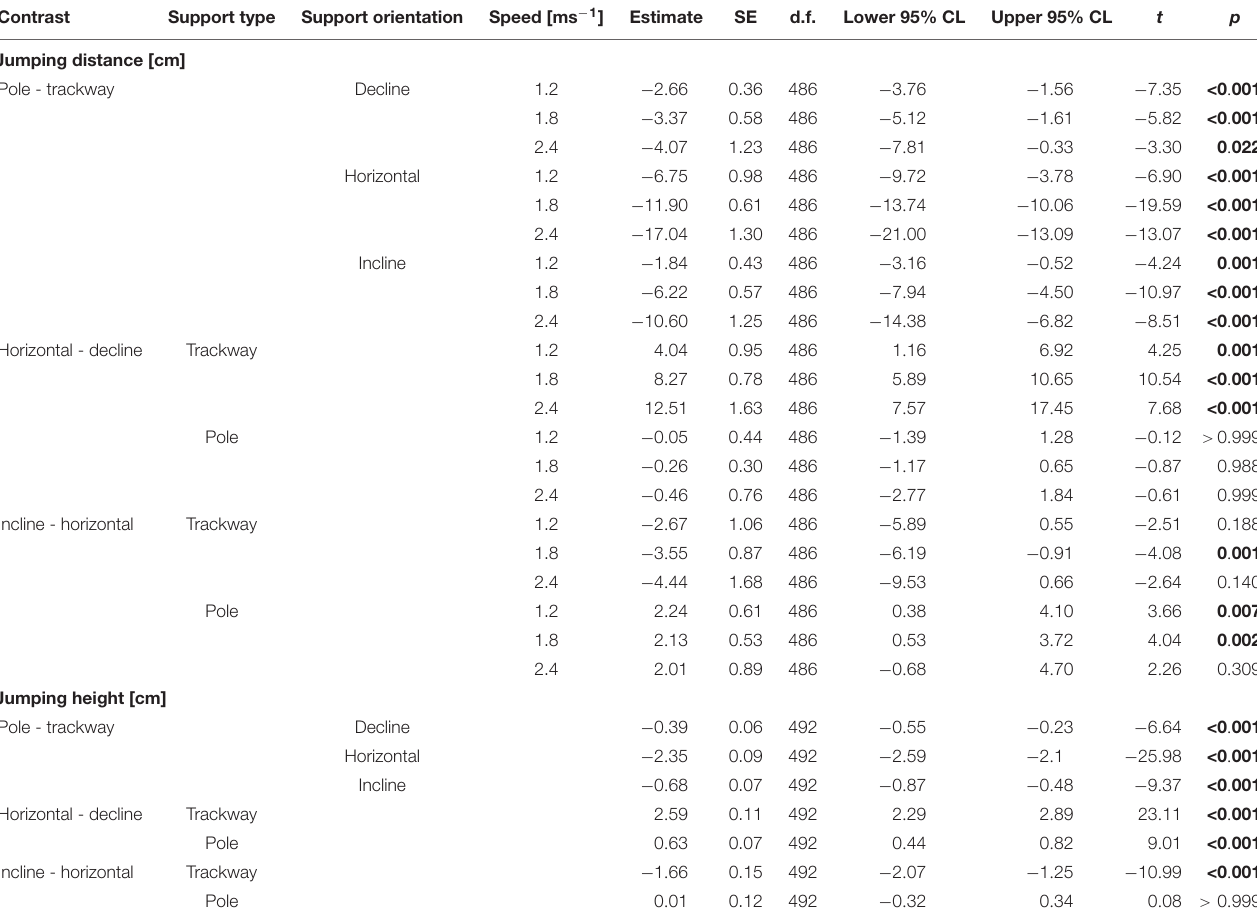
TABLE 4 | Post hoc contrasts for the regressions of jumping distance/jumping height. Contrast Support